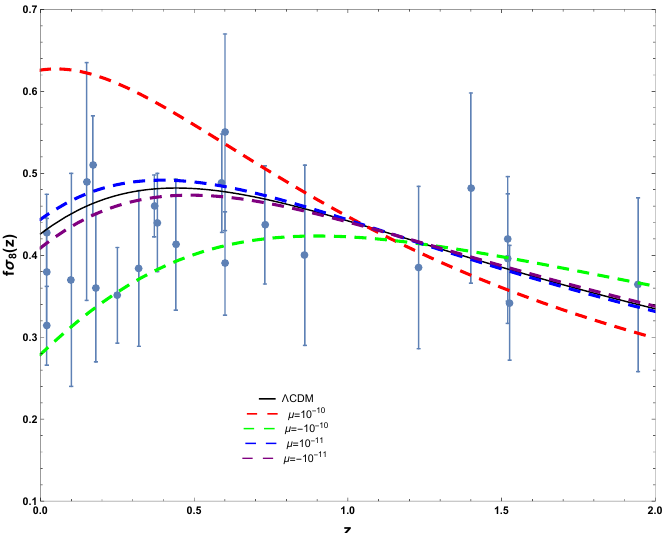
Figure 7. Dependence of f σ 8 ( z ) on z in the presence of anisotropic stresses ( m = α = β = ν = c 2 ε = 0).